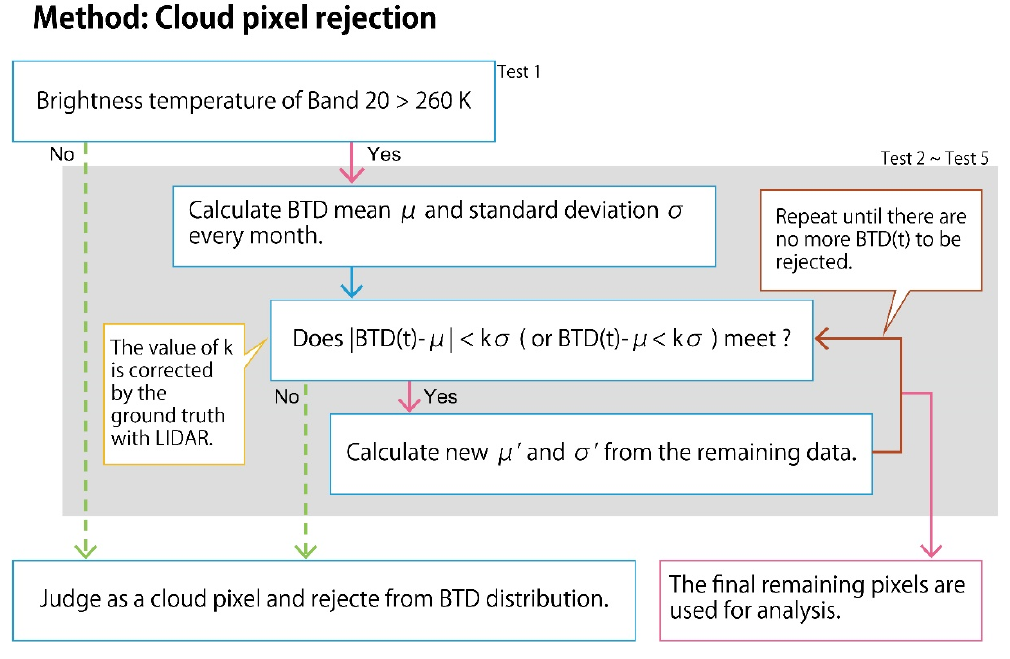
Figure 4. Schematic view of the cloud discrimination method. ( a ) General concept of cloud discrimination. Each test corresponds to the cloud reduction on a different level. ( b ) detailed explanation of the cloud discrimination for Tests 2–5.